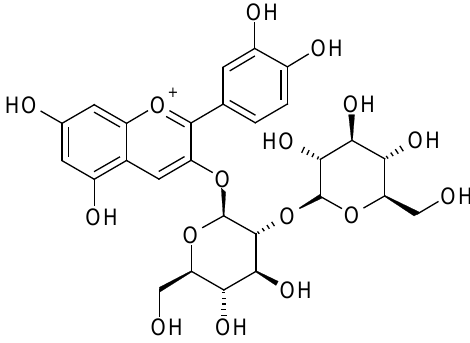
Figure 2. Cyanidin 3- O -sophoroside [28].